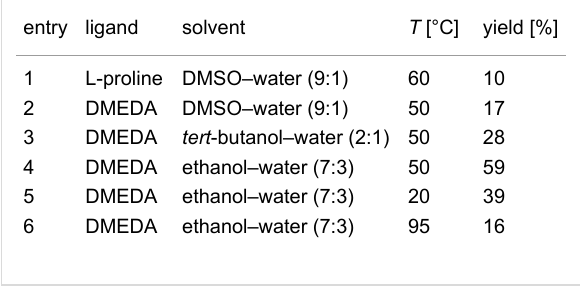
Table 1: Variation of solvent mixture and temperature in Cu(I)- catalyzed cycloaddition reactions of 2-iodothiophene ( 3 ) and 2-ethynylthiophene ( 4 ) to form co-oligomer 5